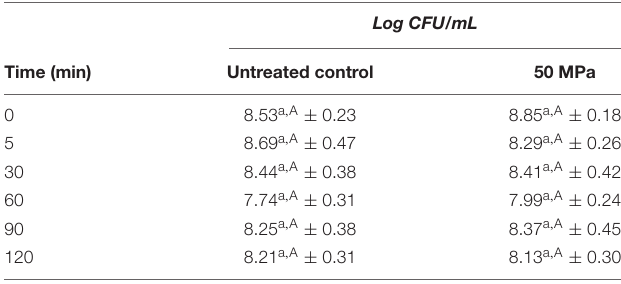
Different lowercase letters indicate significant differences among control and treated samples. For each considered sample, different capital letters indicate significant differences along the